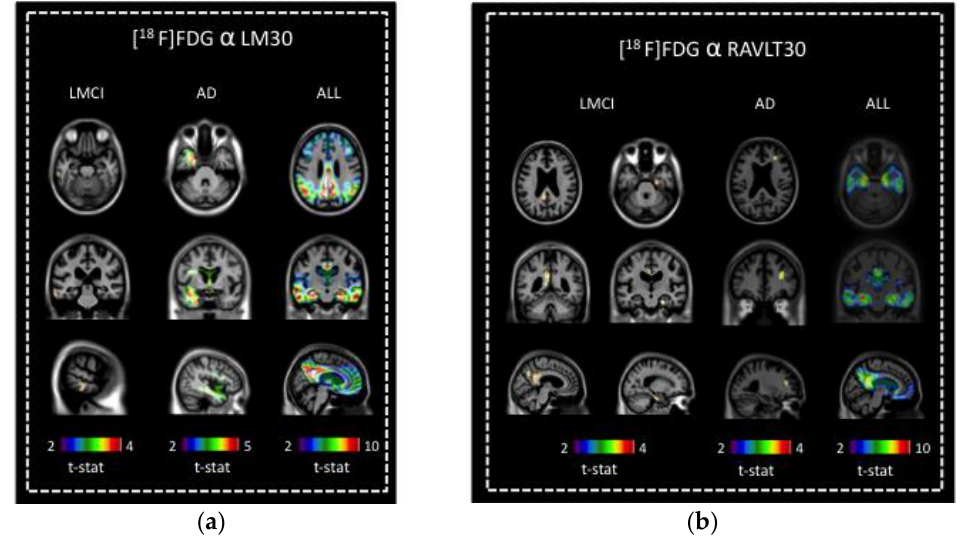
Figure 2. Association between [ 18 F]FDG uptake and memory scores. ( a ) Positive correlations between [ 18 F]FDG uptake and LM30 were observed in the lateral left middle and inferior temporal gyrus of LMCI and in the antero-medial left temporal lobe of AD. For all groups combined, positive correlations between [ 18 F]FDG uptake and LM30 were seen in the frontal and parietal cortices, precuneus, and mesial temporal areas. ( b ) Positive correlations between [ 18 F]FDG uptake and RAVLT30 were observed in the left posterior cingulate gyrus and precuneus and in the right enthorinal cortex of LMCI, and in the right frontal lobe of AD. For all groups combined, there was a positive correlation between [ 18 F]FDG uptake and RAVLT30 in the frontal and parietal cortices, precuneus, and mesial temporal areas.